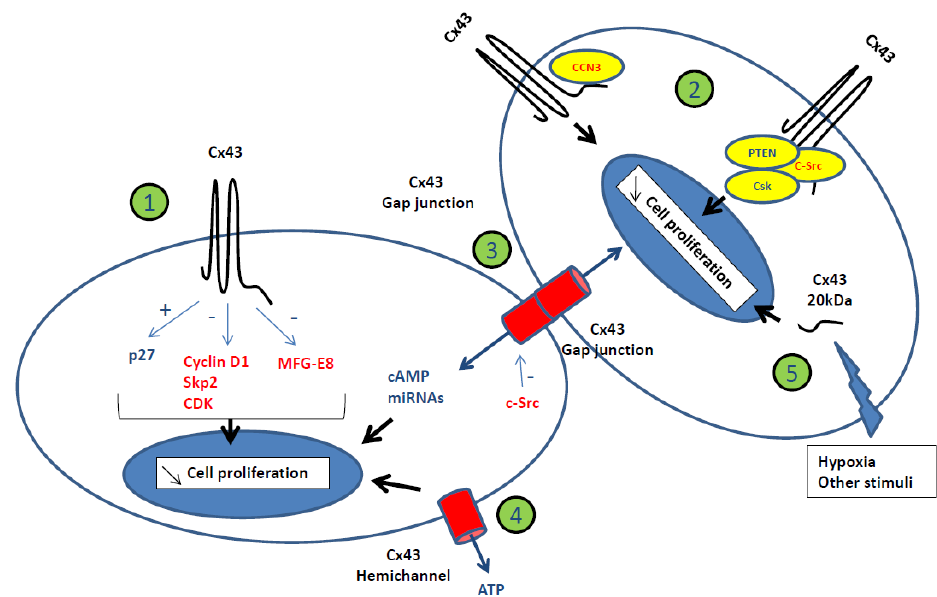
Figure 2. Connexin-mediated negative control of cell proliferation. Cx43 negatively regulates cell growth by acting differently on activators (red) and inhibitors (blue) of cell proliferation. This regulation is mediated through various mechanisms in which Cx43 acts by itself (1), as a sequestrator (2) of growth regulators (e.g., CCN3, PTEN, Csk, c-Src), as a mediator of GJIC (3), through hemichannel activity (4) or its 20 kDa carboxyl tail (CT)-domain (5). These various mechanisms act on the nucleus (thick black arrows) to decrease cell proliferation. Some of these mechanisms are mediated by hemichannel or gap-junction permeability (thick blue arrows). Positive (+)/negative (−) effects of Cx43 on cell cycle regulators (p27, Cyclin D1, etc.) and c-Src effect on Cx43 are also shown (thin blue arrows).